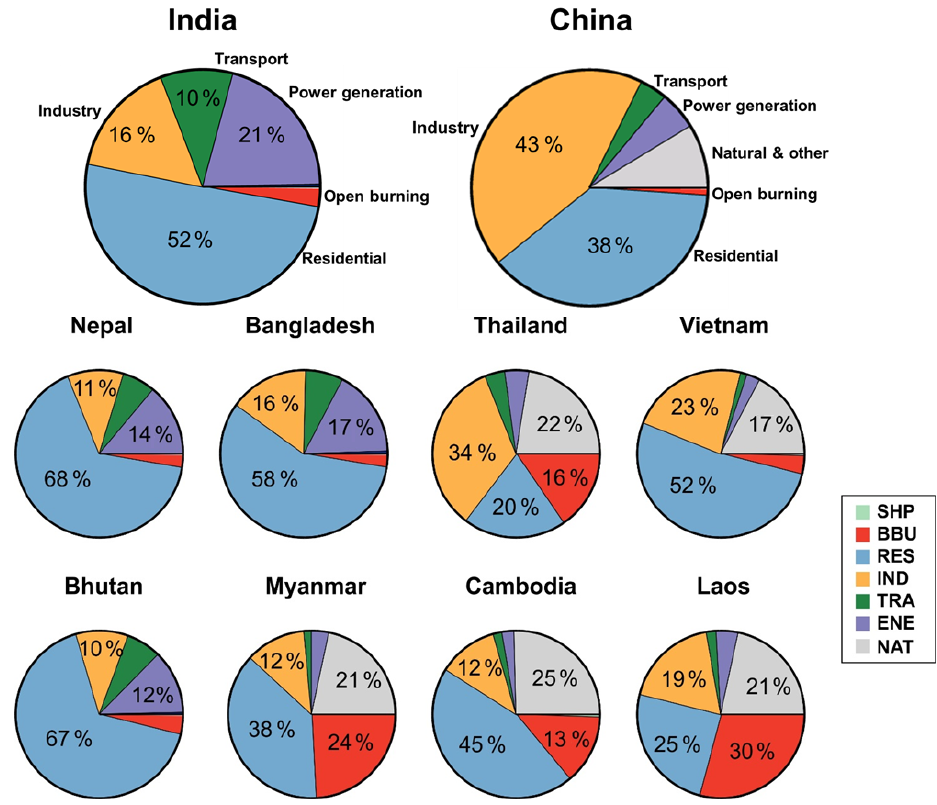
Figure 2. Relative contributions of different anthropogenic emission sectors to population-weighted annual mean PM 2 . 5 concentration by country in South and East Asia. Emission sectors include agriculture (AGR; South Asia only), power generation (ENE), industrial non-power (IND), residential energy use (RES), land transport (TRA), open biomass burning (BBU), and shipping (SHP; China and mainland South-east Asia only). Where the percentage contributions from each sector do not add up to 100%, the residual fraction is assigned to “Natural and other sources” (NAT). Sectors are listed in the legend only if their contribution is visible in the pie charts. Relative contribution values of 10% or greater are shown in the quadrants. Results are shown for the region of China contained within the model domain, which accounts for 92% of the Chinese population (Sect.